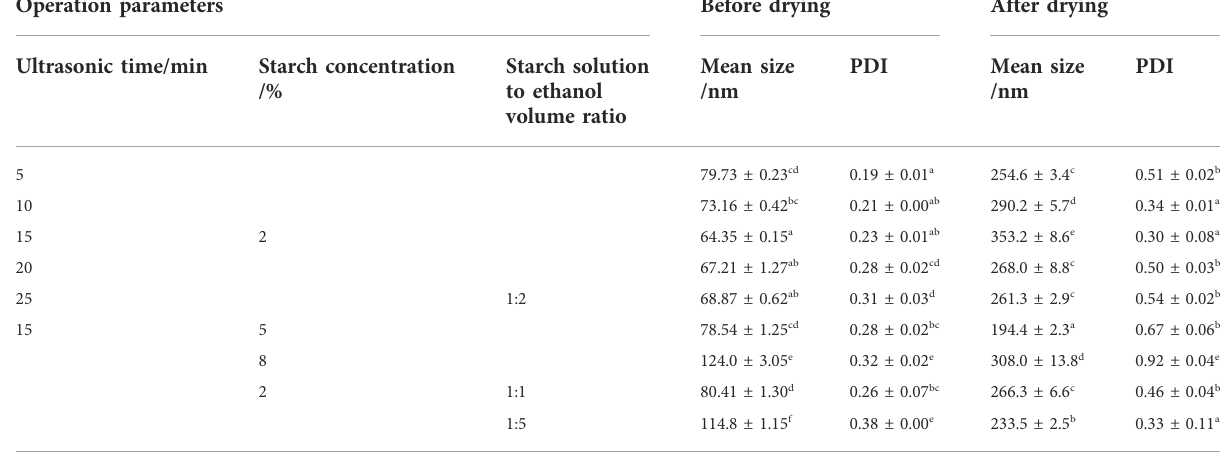
TABLE 1 Mean particle size and PDI of SNPs obtained by different preparation parameters before and after freeze-drying. Operation parameters Before drying After drying Ultrasonic